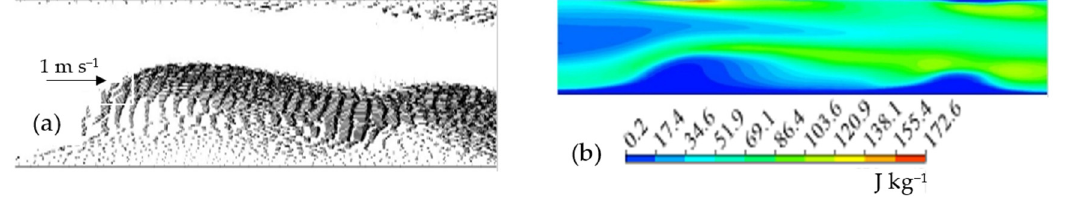
Figure 11. An example of instantaneous snapshot of the air and water two-phase flow development displayed at water wavy flow velocity of 1 m s − 1 : ( a ) velocity vectors of water fluid; ( b ) contours of turbulence kinetic energy of air flow.